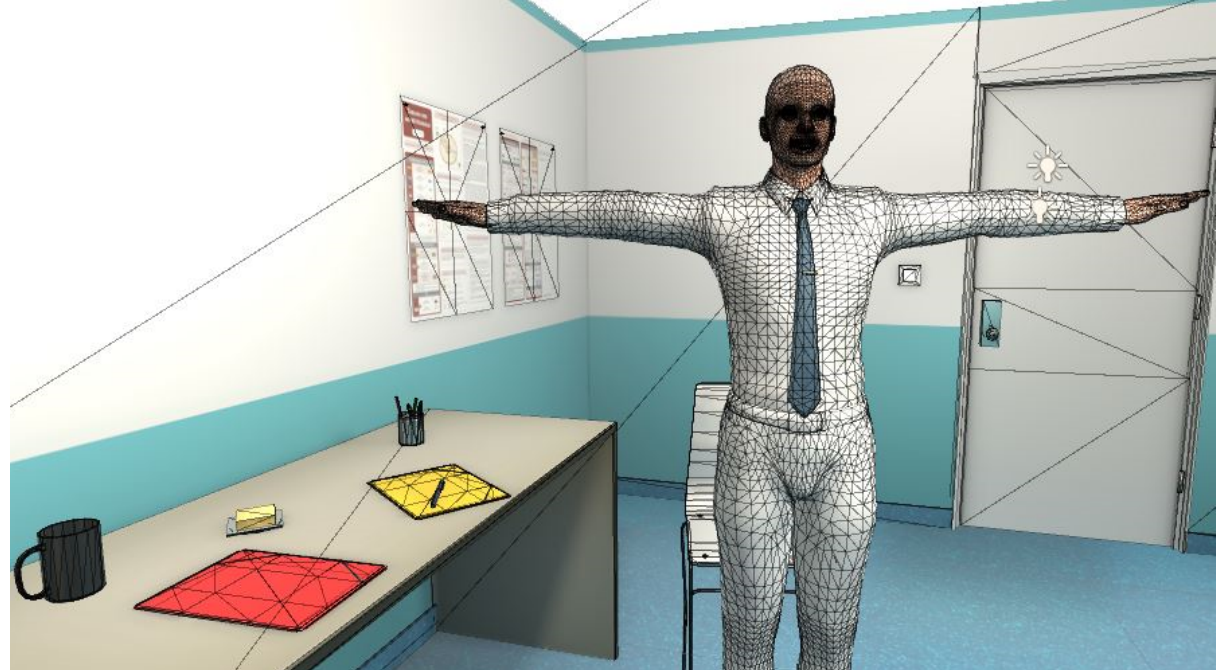
Figure 6. 3D Virtual